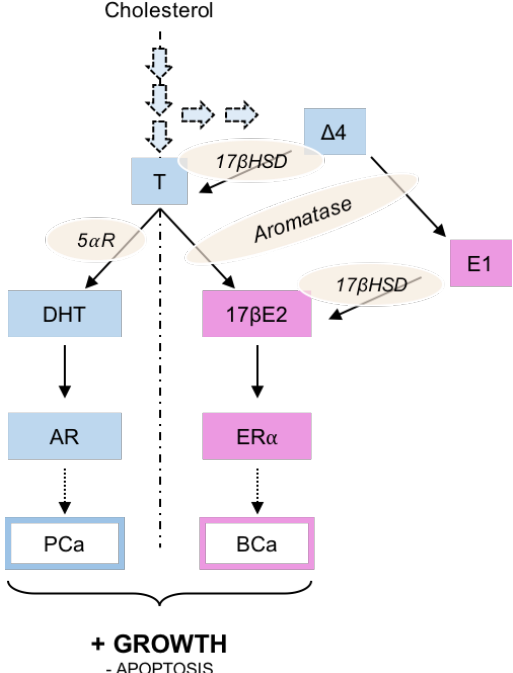
Figure 1. Schematic representation of the steroid activity on prostate (PCa) or breast (BCa) cancer. Three various levels of control could be pointed out: i) steroid synthesis by inhibiting the enzymatic pathways leading to testosterone or 17 β -estradiol production; ii) modulation of the androgen or estrogen receptor activity using specific antagonists; iii) modulation of the steroid receptor activity together with the induction of its degradation / down-regulation. ∆ 4, ∆ 4-androstenedion; 5 α R, 5 α -reductase; 17 β E2, estradiol; 17 β HSD, 17 β -hydroxy-steroid dehydrogenase; AR, androgen receptor; BCa, breast cancer; E1, estrone; ER α , estrogen receptor α ; PCa, prostate cancer; T, testosterone.